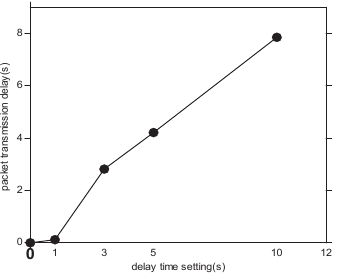
Figure 9. Packet transmission delay after using new mechanism As with the third facet, experiments were conducted on every single application and the combination of the three (see Fig.10).